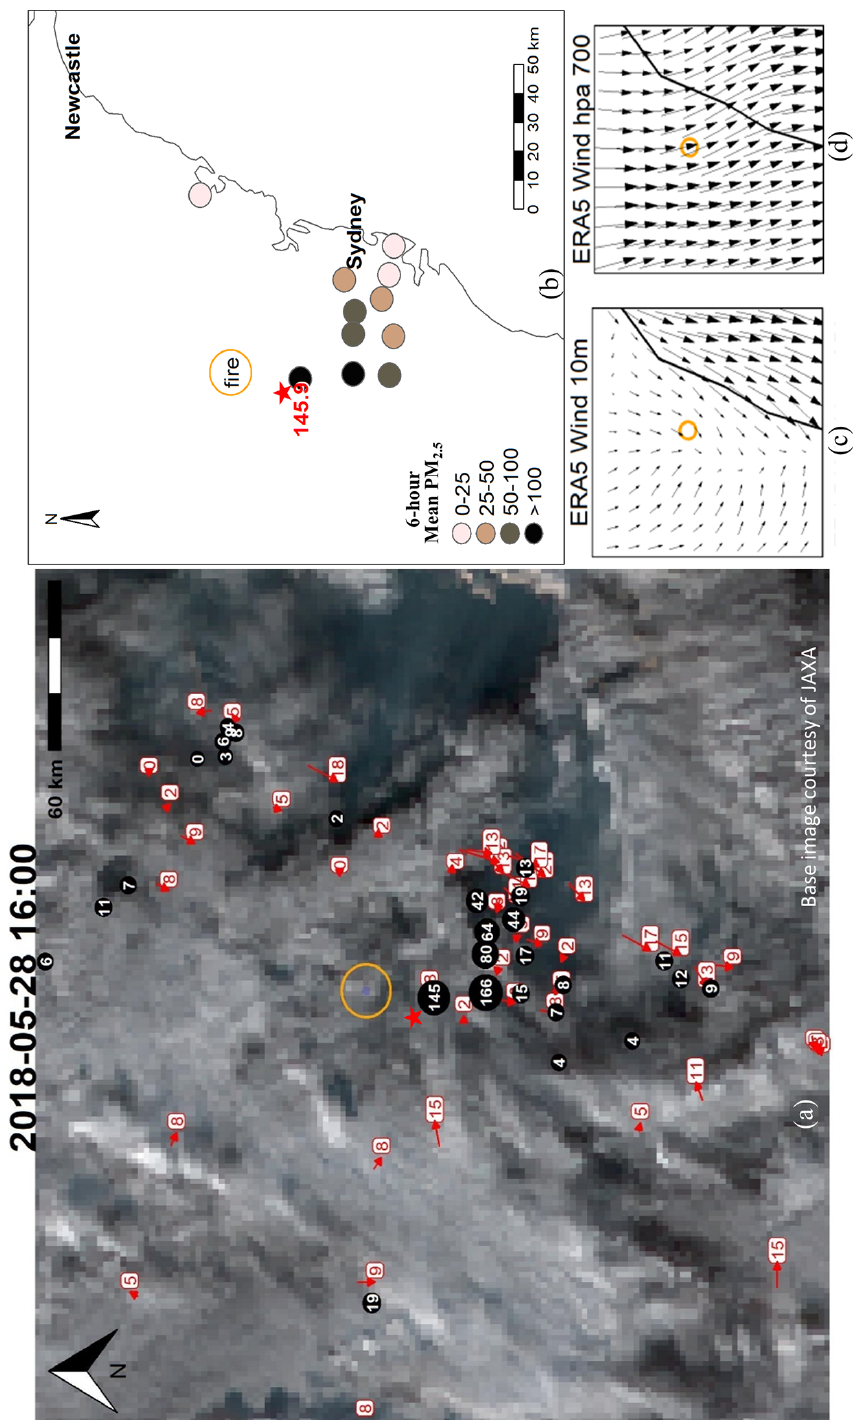
Figure A5. HRB afternoon. The highest mean afternoon HRB PM 2 . 5 was 145.9µgm − 3 at the closest AQS in Richmond (red star). Four other AQSs also recorded PM 2 . 5 > 50µgm − 3 during the same period (b) . Wind patterns at 10m (c) suggest that the northerly winds and the meeting of NW and NE winds to the west of the fire funnelled surface smoke to Sydney, similarly to in Fig. A2. Wind speeds were also low (a, c) , meaning smoke would have remained in the area for longer. On the morning preceding this period, there was likely some smoke lingering around Sydney because several AQSs recorded hourly values in the twenties and thirties (µgm − 3 ). The synoptic wind direction (d) in the afternoon was northerly, meaning high-level smoke would also have flowed towards Sydney. PM 2 . 5 continued to increase as the day went on and into the night. The highest night mean PM 2 . 5 was also caused by this HRB (Fig. A6). https://doi.org/10.5194/nhess-22-4039-2022 Nat. Hazards Earth Syst. Sci., 22, 4039–4062,